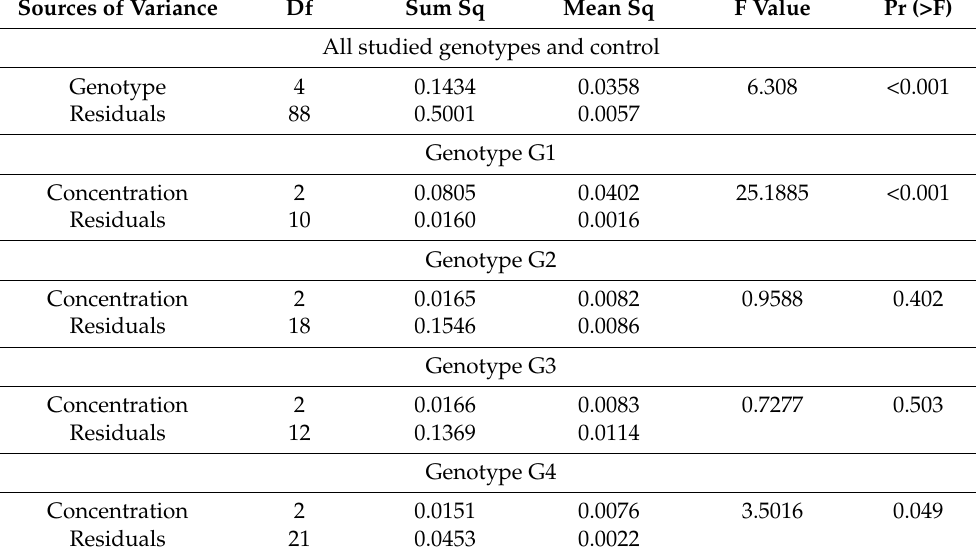
Table 5. Analysis of the variance of genotypes: G1–G4 under the influence of salinity and control. Df—degrees of freedom, Sum Sq—sum of squares, Mean Sq—mean square, F value—F statistic, Pr (>F)— p -value.